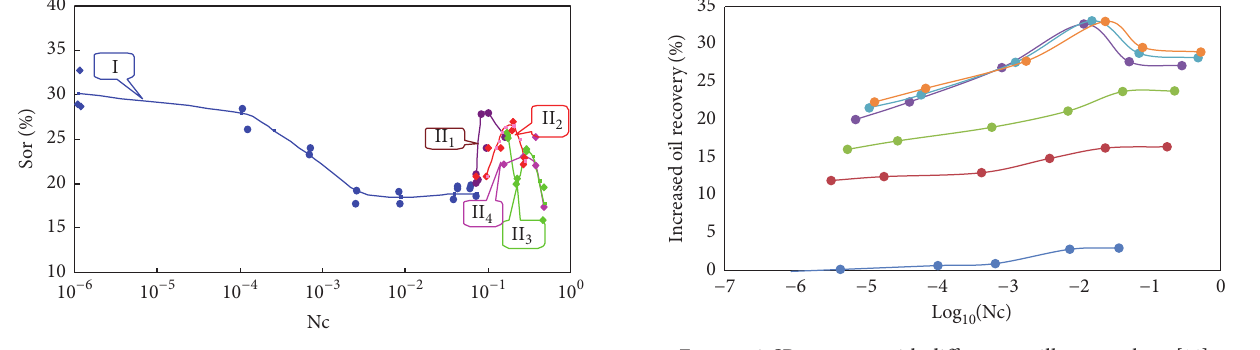
Figure 5: Different CDC [33–36, 62]. Figure 6: SP recovery with different capillary numbers